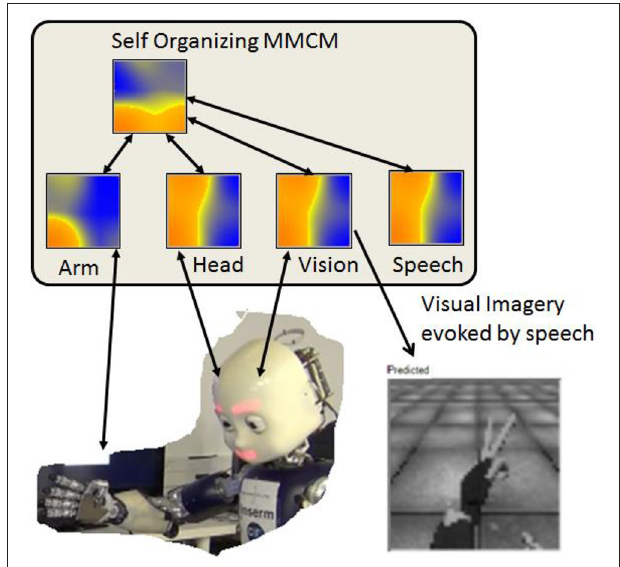
FIGURE 7 | Body schema. Multi-modal convergence map model merging proprioception, vision, and language. Arm and Head are 50 × 50 maps taking as input the robot encoders (left \ _arm = 16 degrees of freedom and head = 6); the speech is a 50 × 50 map fed by a string (converted to a vector of double). The vision is from the iCub left eye camera, gray scaled and cropped to a fovea area and rescaled to an experiment dependent resolution (from 15 × 15 to 320 × 240). These low level maps converge to the multi-modal convergence map. Then, activation of a single input map activates the MMCM which by divergence activates the other input maps. The image of the hand is actually reconstructed from input to the vision map from the stimulated MMCM. From Lallee and Dominey